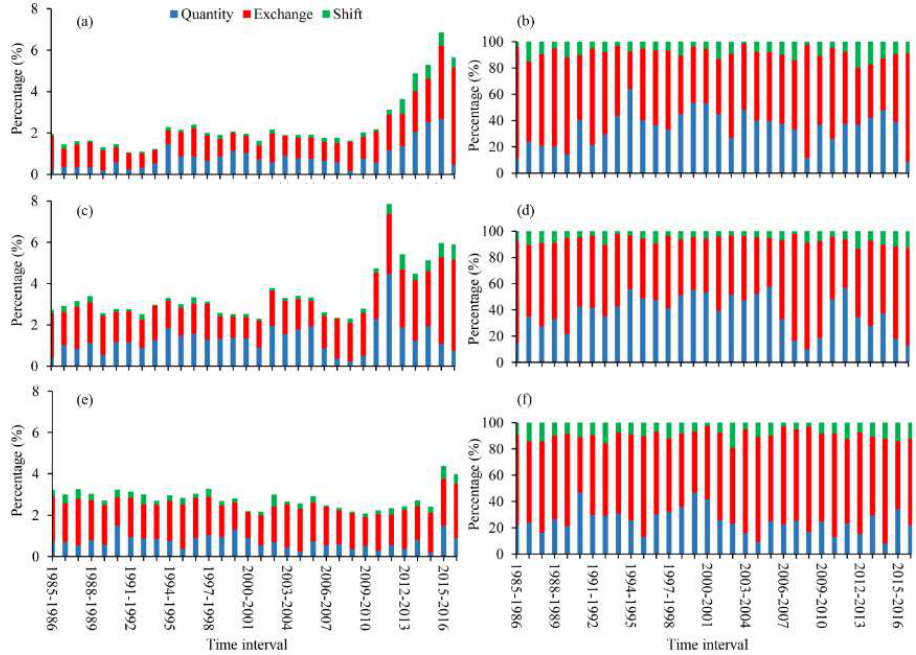
Figure 3. Change component percentage of the region (left panel) and percentage of change (right panel) in upstream ( a and b ), midstream ( c and d ), and downstream ( e and f ) regions at interval level for all land use and land cover (LULC) classes, respectively.